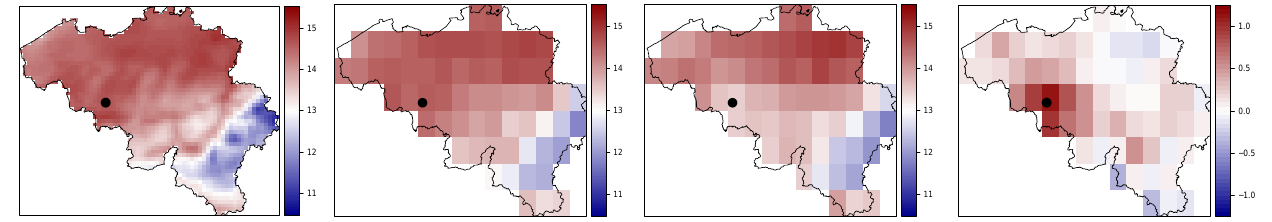
Figure 7. Averaged value for TX over the 34 years [ ◦ C]: FORBIO (4km resolution), FORBIO (25km resolution), E-OBS (25km resolution), differences between FORBIO and E-OBS. The black dot corresponds to the Chièvre